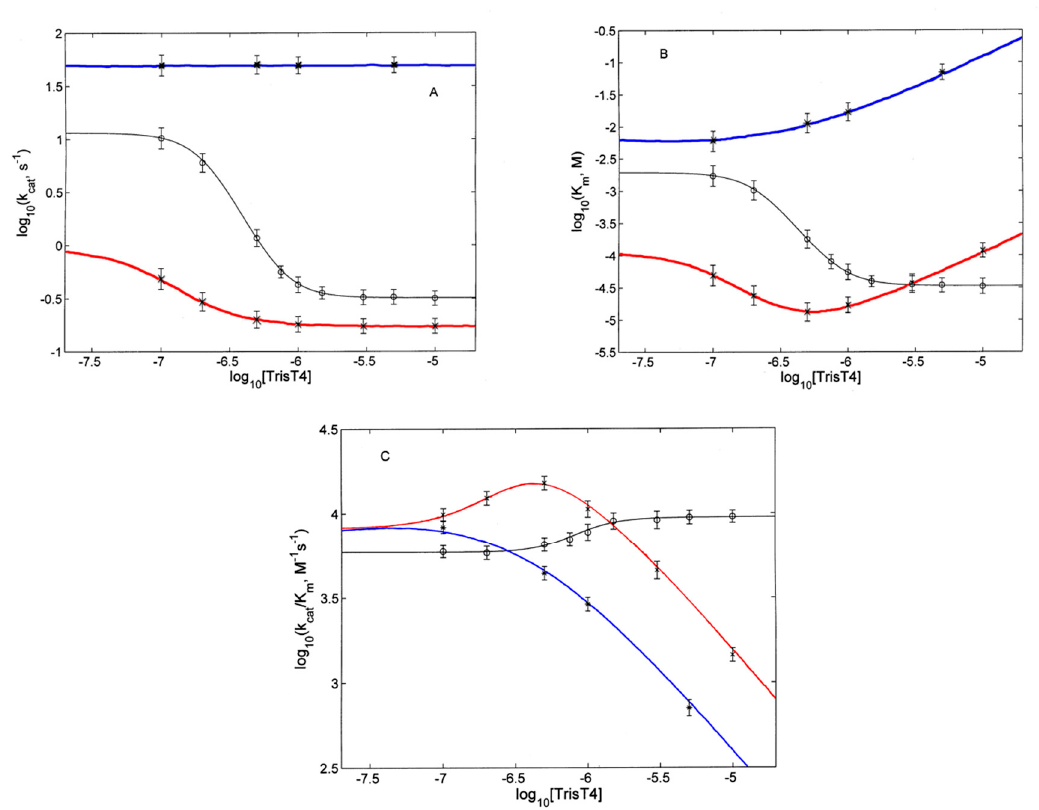
Figure 5. Dependence on Tris-T4 concentration for human (o; black line), wild type yeast (x; red line) and yeast α 3 ∆ N mutant (*; blue line) 20S proteasome for k cat (panel A ), Km (panel B ) and k cat / K m (panel C ). Continuous lines are obtained by non-linear least-squares fitting of data according to Equations (1)–(3), respectively, employing parameters reported in Table 1.